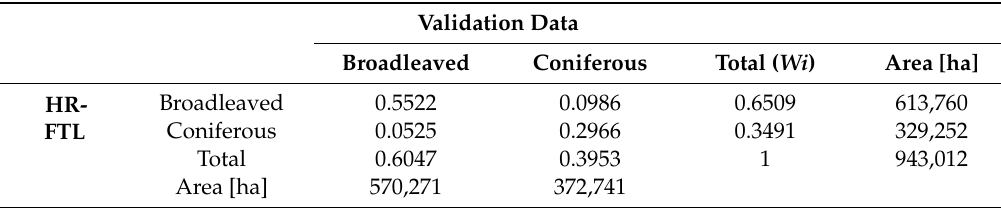
Table 10. Error matrices of estimated proportions of area for the HR-FTL in